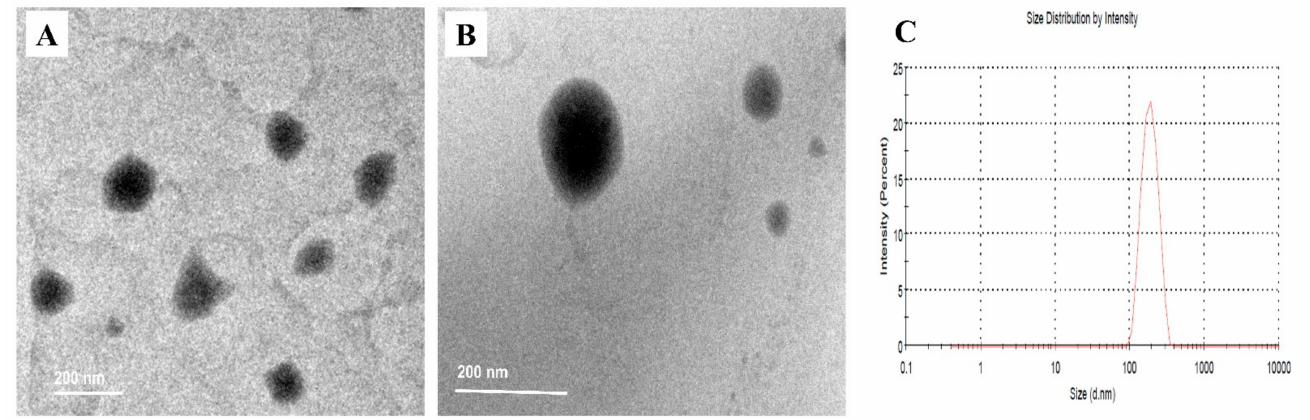
Figure 3. TEM morphology of ( A ) BER-NLCs, ( B ) BER-CTS-NLCs, and ( C ) particle size and PDI of